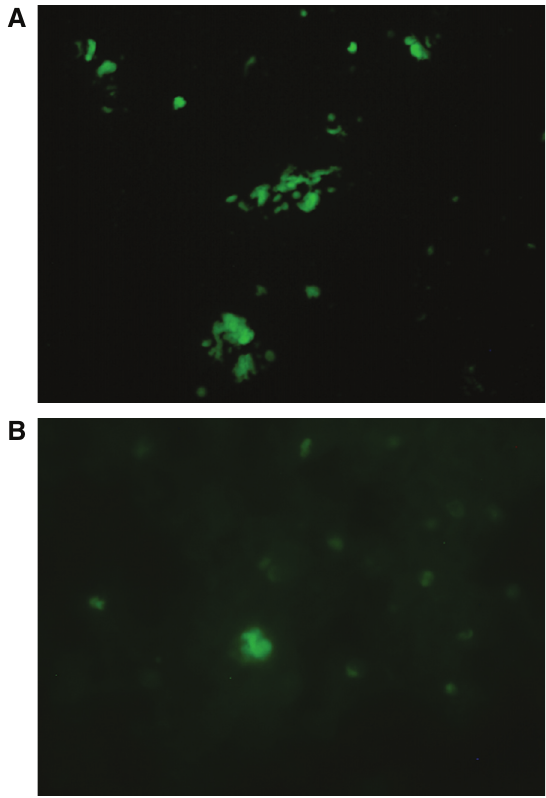
Figure 3. A : Molecular hybridization of B. burgdorferi -specific FlaB probe with seminal culture from Patient 6. Note intensely staining spiral and round forms in culture. 400× magnification. B : Molecular hybridization of B. burgdorferi -specific FlaB probe with vaginal culture from Patient 7. Note intensely staining spiral and round forms in culture. 400× magnification. See Dataset, data file